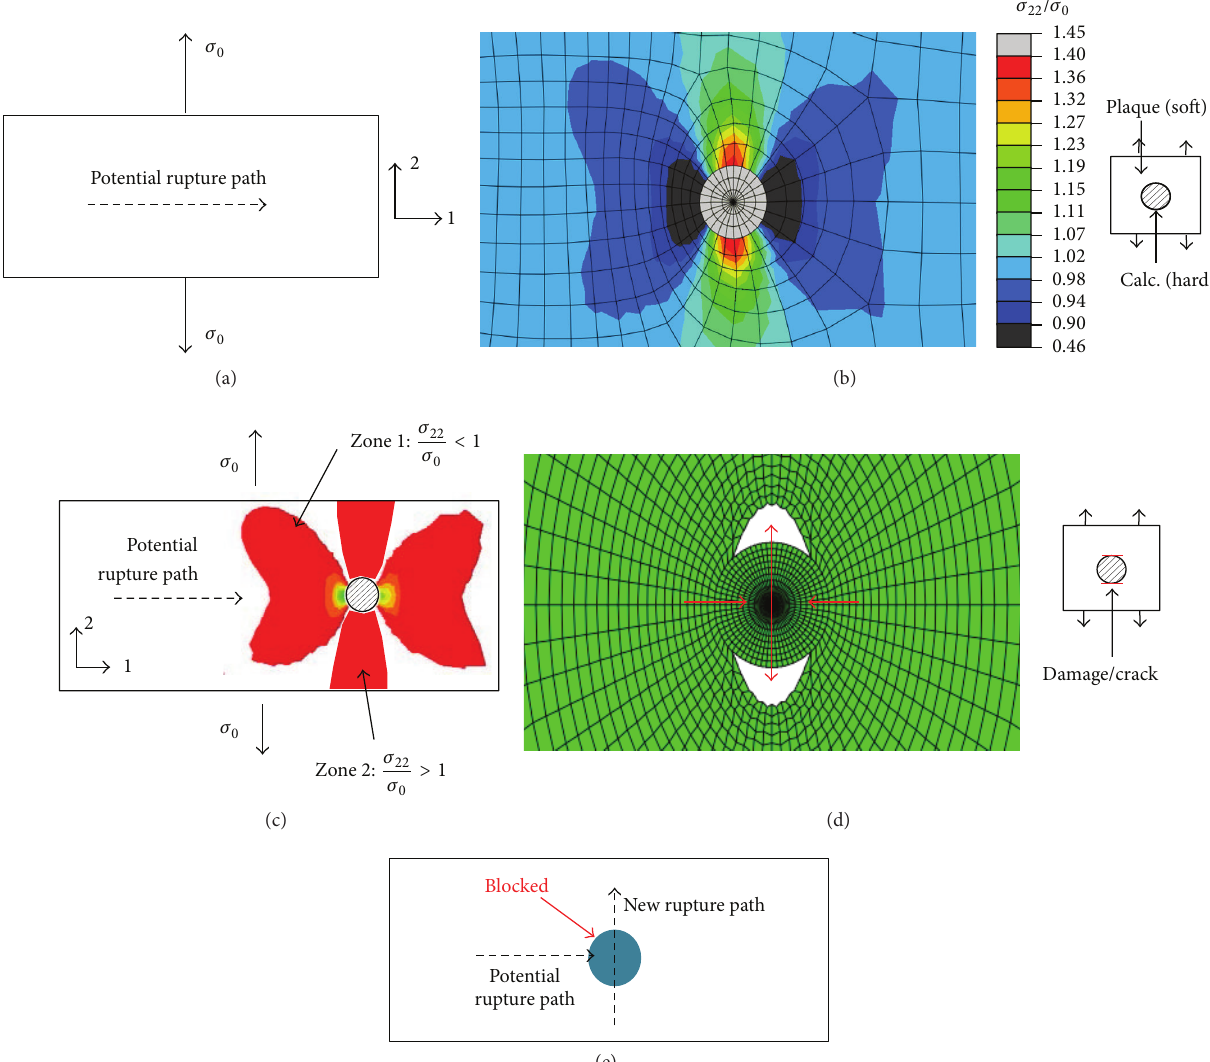
Figure 6: Diagram of the possible mechanism of reducing rupture